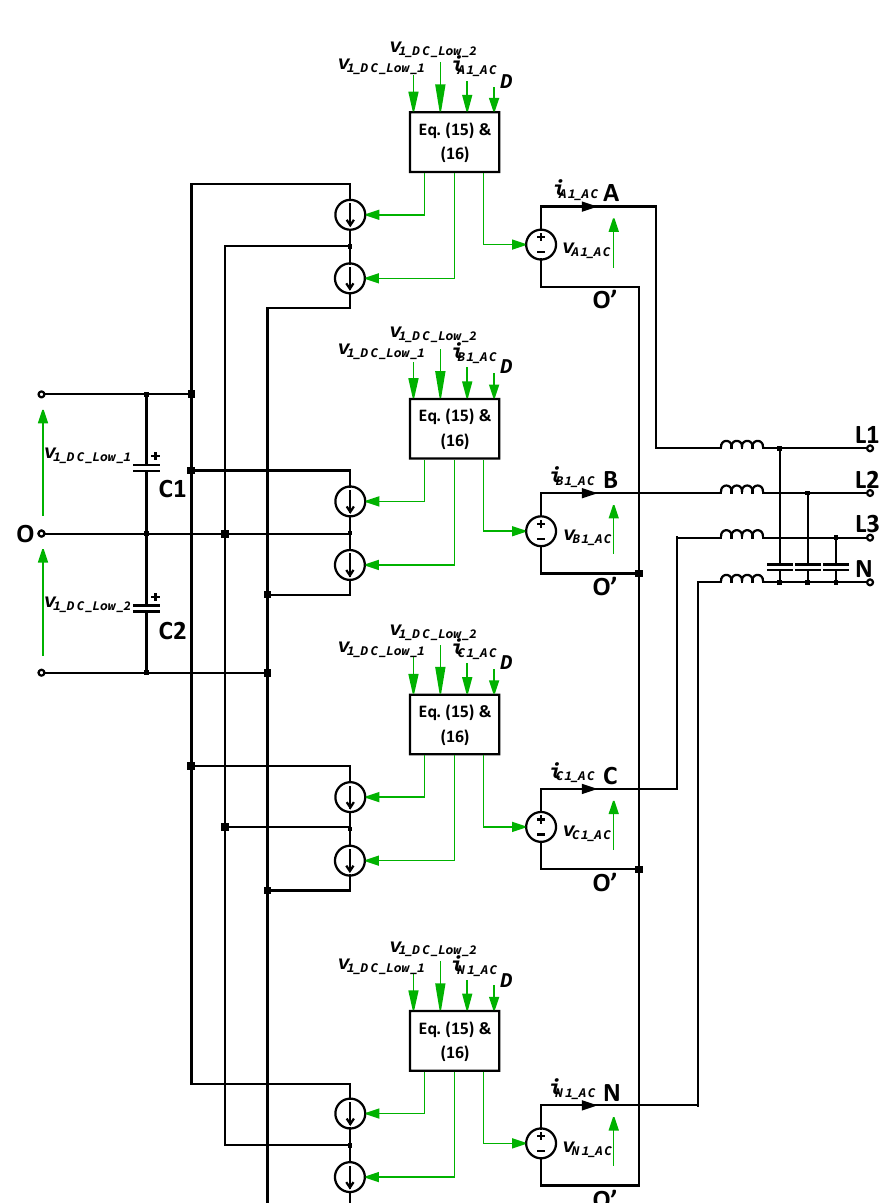
Figure 8. The average model of the one T-type module in the DC-AC converter.